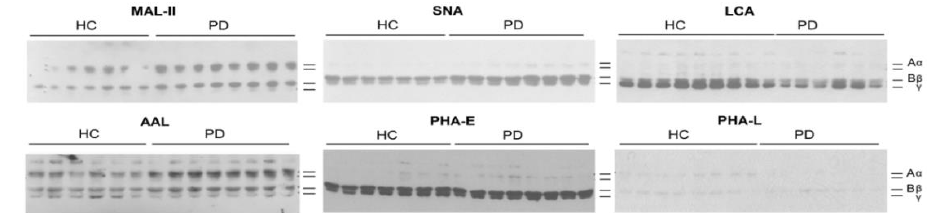
Figure 4. Lectin blots of fibrinogen samples resolved under reducing SDS-PAGE and incubated with biotinylated lectins. ESRD patients on peritoneal dialysis (PD) and healthy controls (HC). Positions of fibrinogen chains are marked on the right.